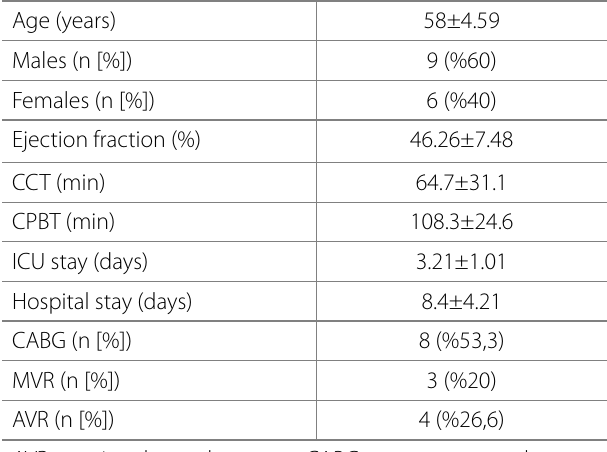
Table1 . Patients’ general